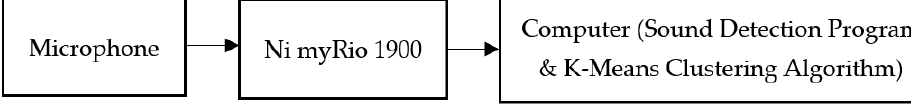
Figure 2. System structure of hardware.